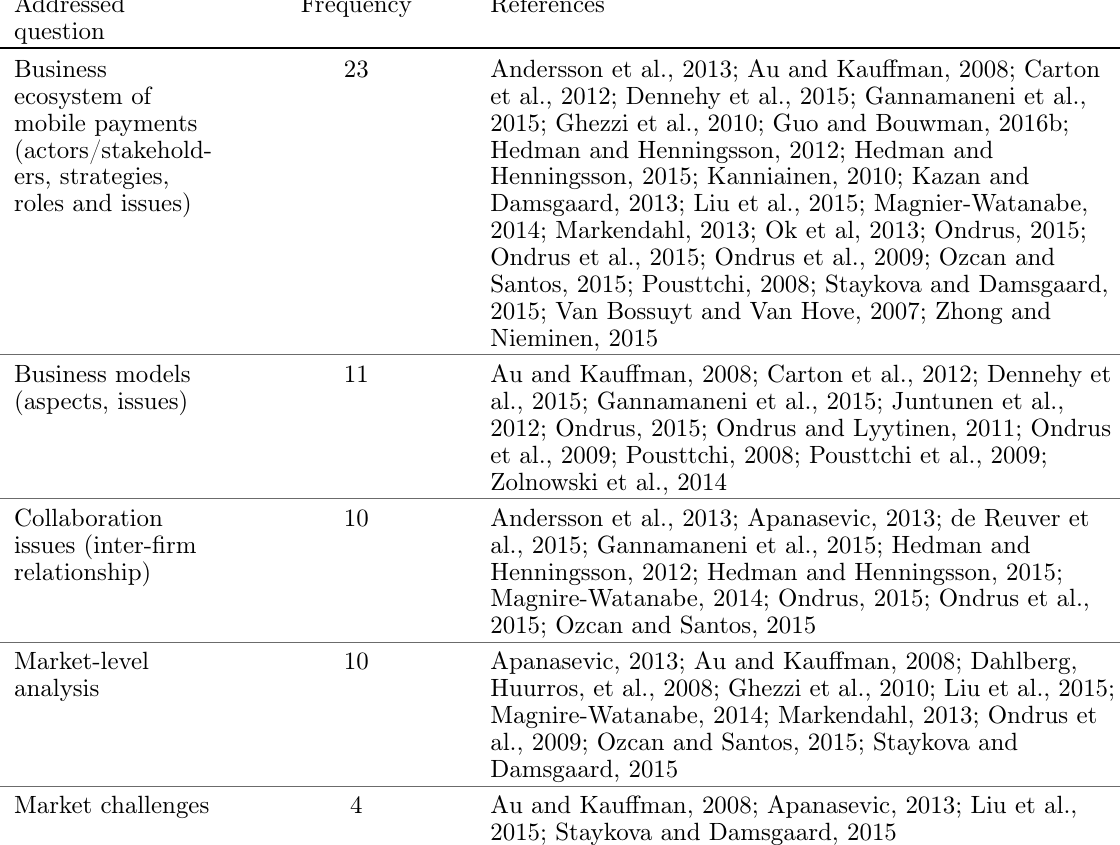
Table E.1. Classification of papers on business aspects by